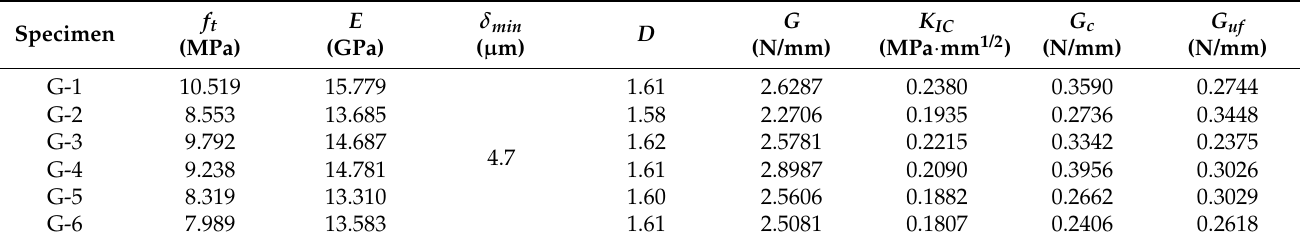
Figure 4. Box-counting method double logarithmic diagram for slate and granite. Table 2. Test data and calculation results of granite specimens.